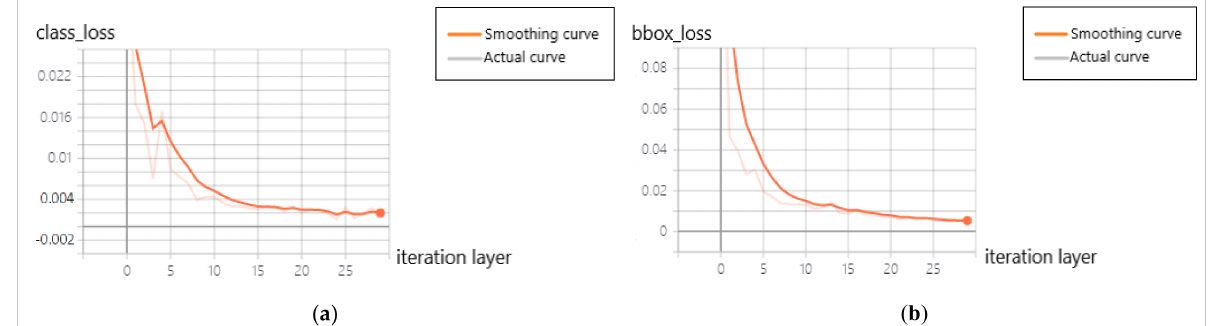
Figure 21. Faster R-CNN loss function 3. ( a ) Class loss, ( b ) bbox